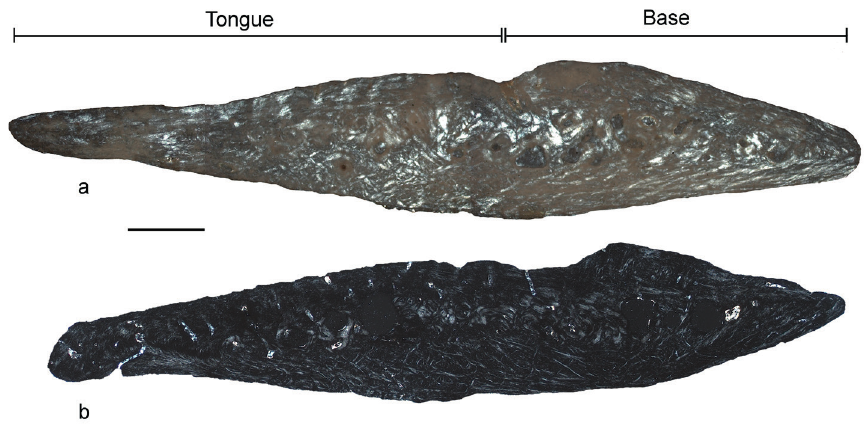
Figure 2 - Longitudinal section of osteoderms from movable bands of Riostegotherium yanei , to the right. Polarized